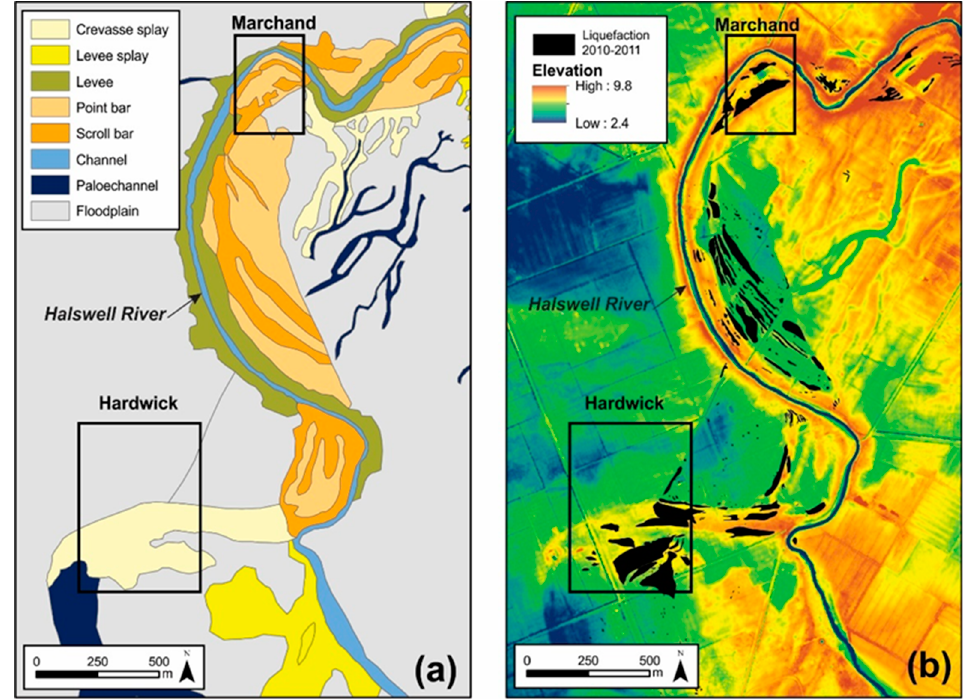
Figure 9. ( a ) Geomorphic map of the Halswell River study area and ( b ) digital elevation model (DEM) from light detection and ranging (LiDAR) with the locations of the 2010–2011 liquefaction sand blows (black polygons) [29]. The aerial photograph shown in Figure 10 is of the Hardwick site outlined by a black rectangle.